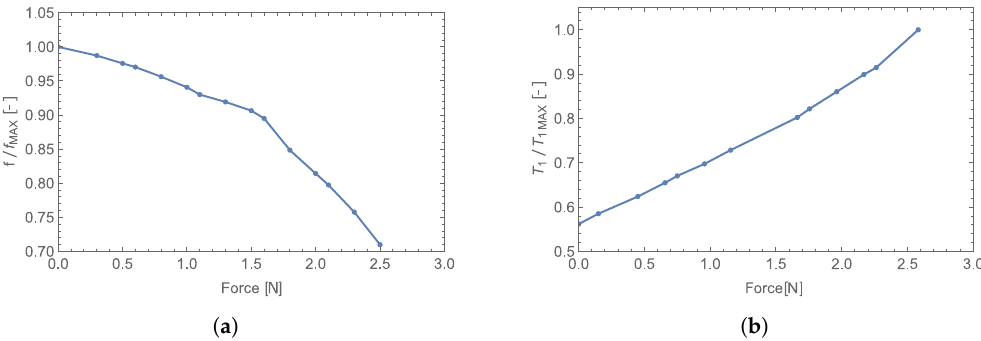
Figure 18. Normalized transfer characteristic (measured with evaluation of reflected wave) ( a ). Normalized transfer characteristic (measured with evaluation of DC supply current of VCO ) ( b